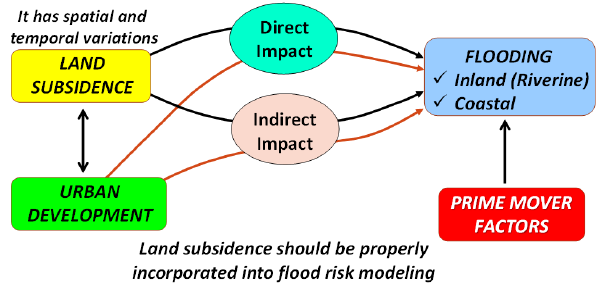
Figure 8. Flood risk modeling which incorporates land subsidence phenomena in